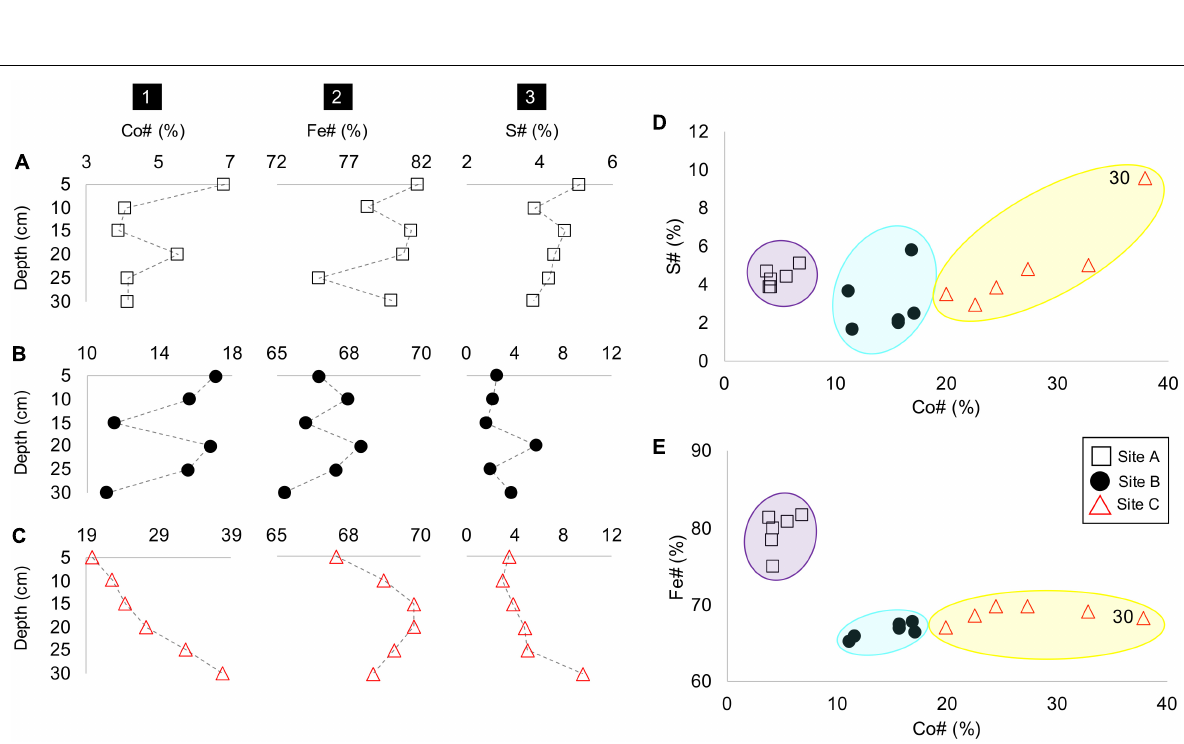
FIGURE 5 | Depth profiles of sites A to C (rows A–C ) with columns as (1) Co#, (2), Fe# and (3) S# vs. depth (cm); Co# vs. S# (in panel D ); and Fe# (in panel E ), with site groupings encircled in purple (site A), blue (site B), and yellow (site